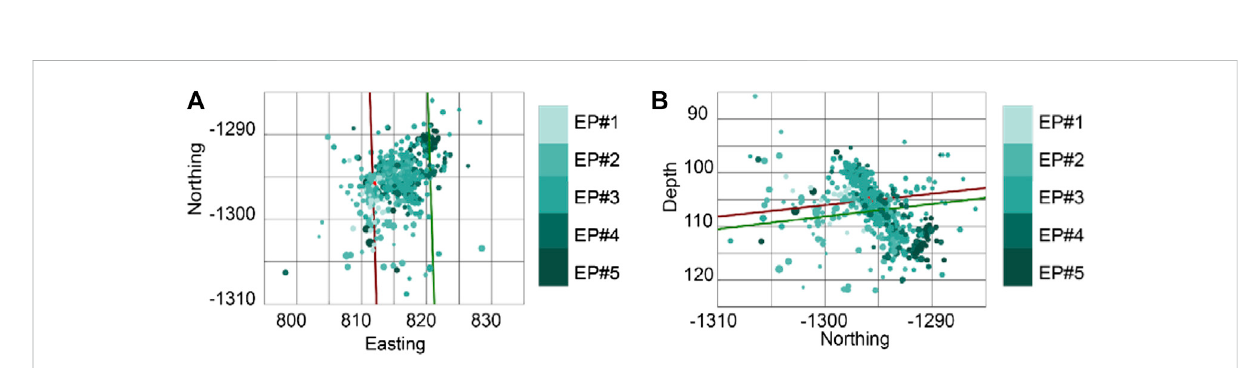
FIGURE 7 Top view (A) and side view (B) of the 3D permeability map show the fracture propagation and potential fl uid